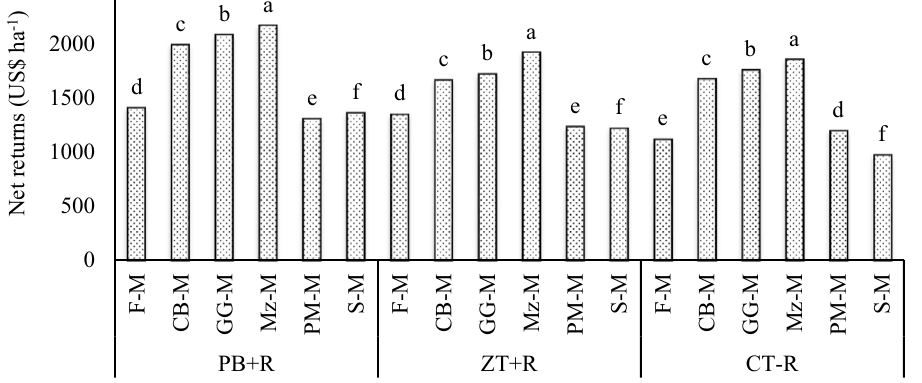
Figure 2. Net return of different CA-based Indian mustard systems (3-year mean).